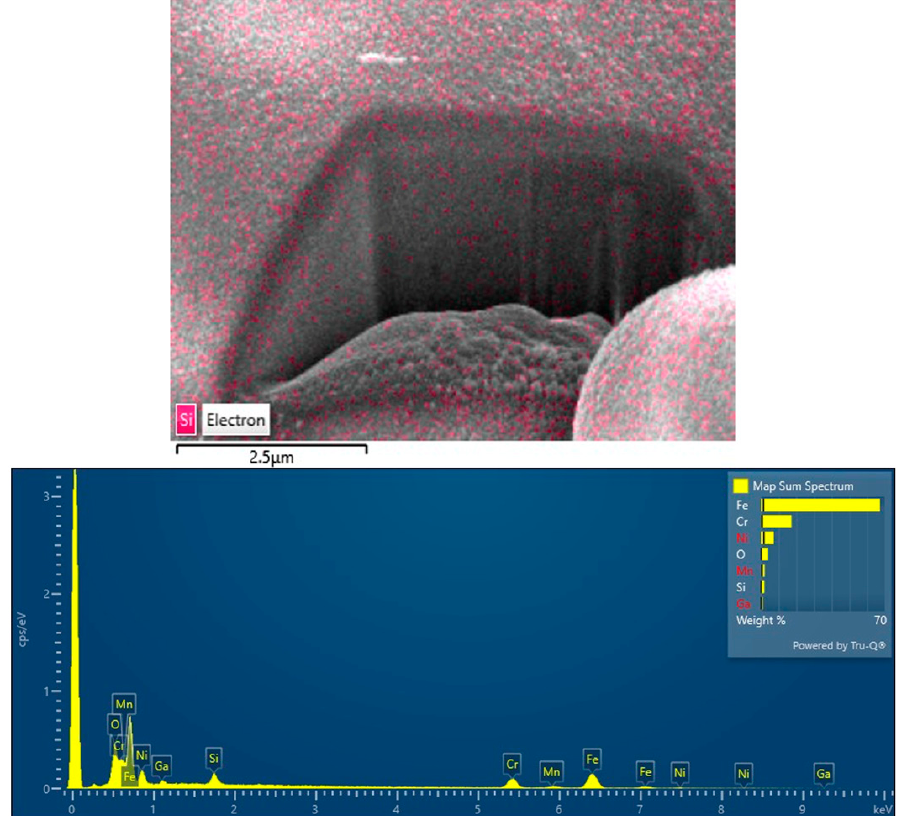
Figure 17. EDX spectrum and silicon particle distribution around cross-section obtained by FIB machining of surface textured with parallel lines scanning strategy at 12 W: Surf 3 sample (laser texturing + sol–gel (APTES + PE